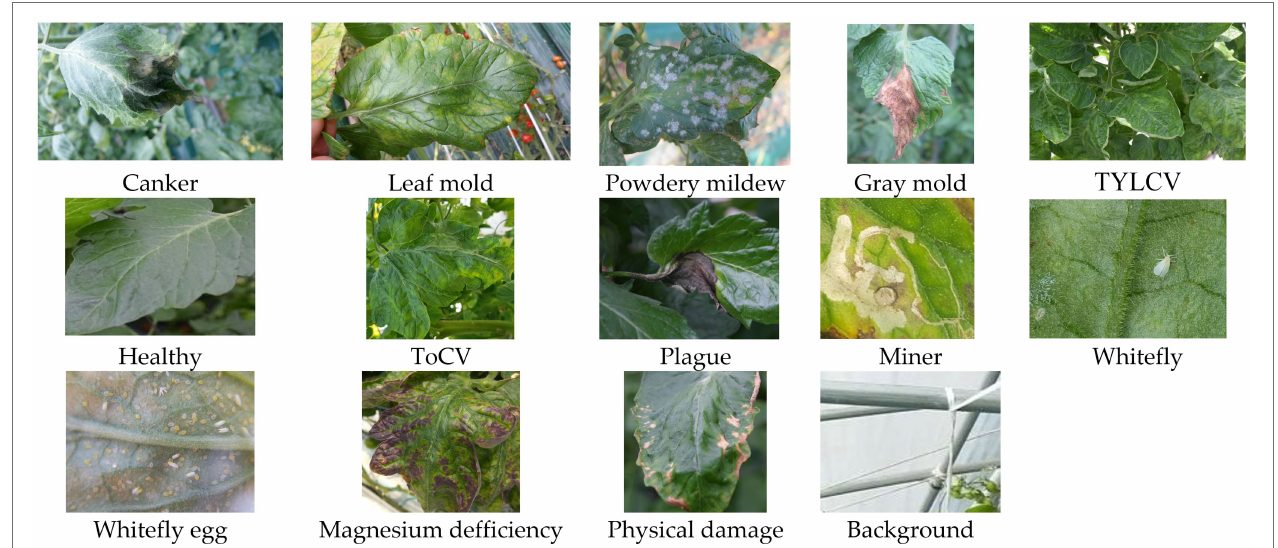
FIGURE 2 | Example of collected images and types of diseases of our